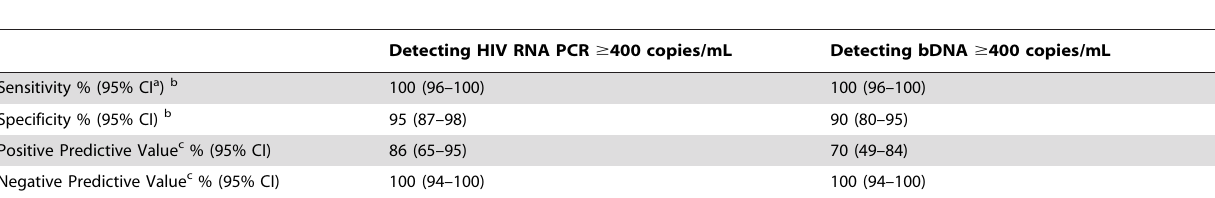
Table 2. Characteristics of the Cavidi H reverse transcriptase assay for detecting HIV viral loads $ 400 copies/mL using RNA PCR or branched DNA assay (bDNA) assays in patients receiving antiretroviral